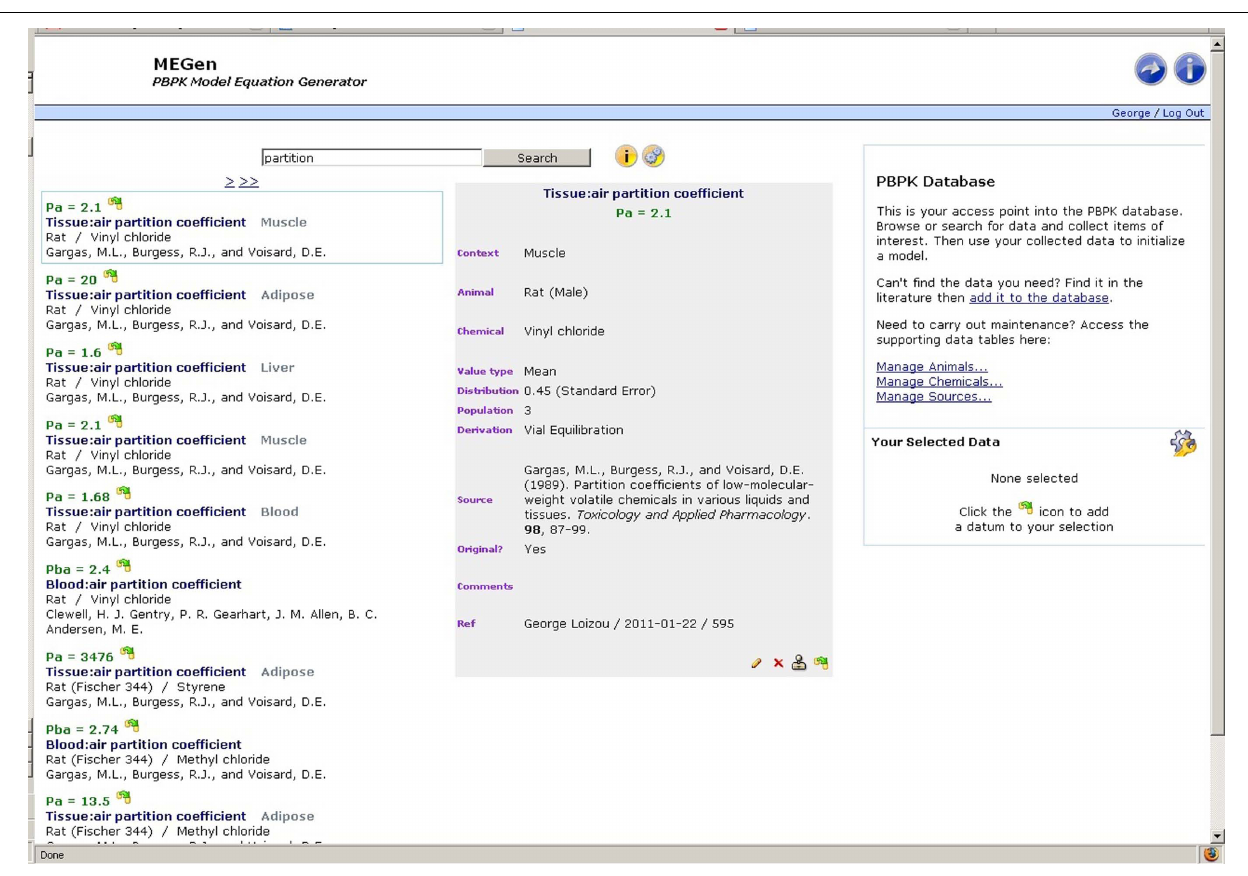
FIGURE 2 | Database search page showing details of a selected parameter.